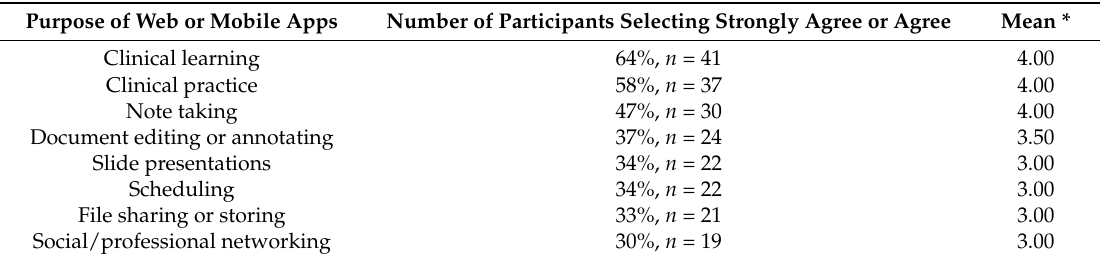
Table 1. Types of tools perceived more positively by the